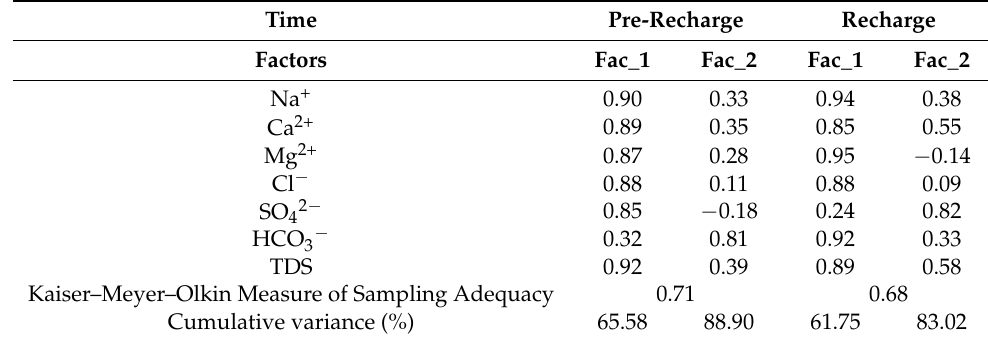
Figure 9. Gibbs diagram of the research area. ( a ) The relationship between Na + /(Na + + Ca 2+ ) and TDS. ( b ) The relationship between Cl − /(Cl − ＋ HCO 3 − ) and TDS. Table 2. Results of Principal Component